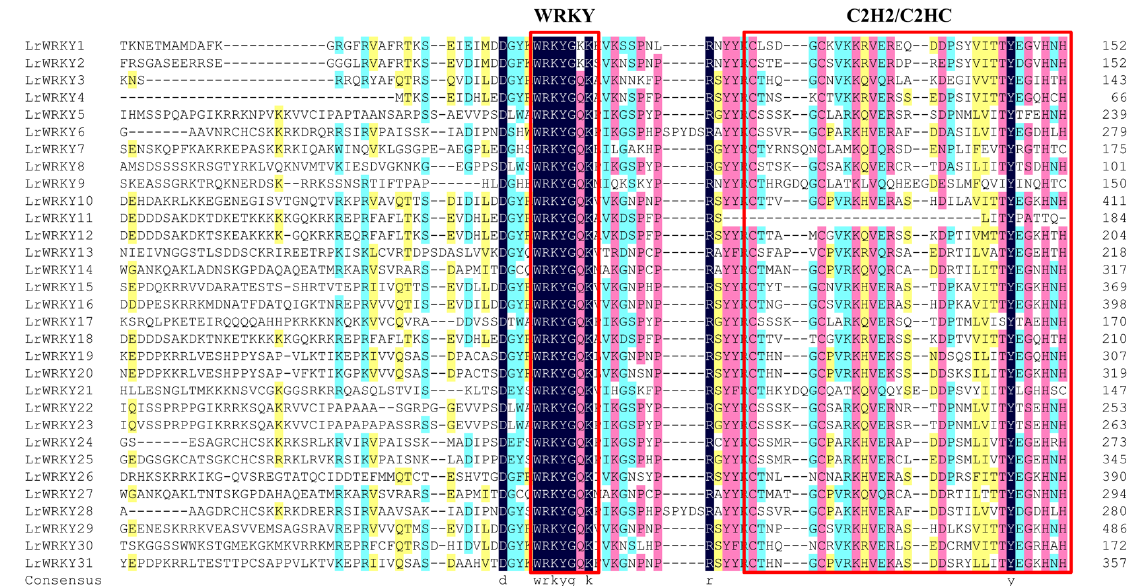
Figure 3. Sequence alignment of 31 LrWRKY proteins. A screenshot of the MEGA X version 10.2.6, showing variation in the conserved domain (WRKYGQK) of LrWRKY proteins and the variation of the conserved domain is encircled in different colors. The yellow boxes indicate 30% identity of amino acids, the blue boxes indicate 50% identity of amino acids, the red boxes indicate 75% identity of amino acids, and the black boxes indicate 100% identity of amino acids.